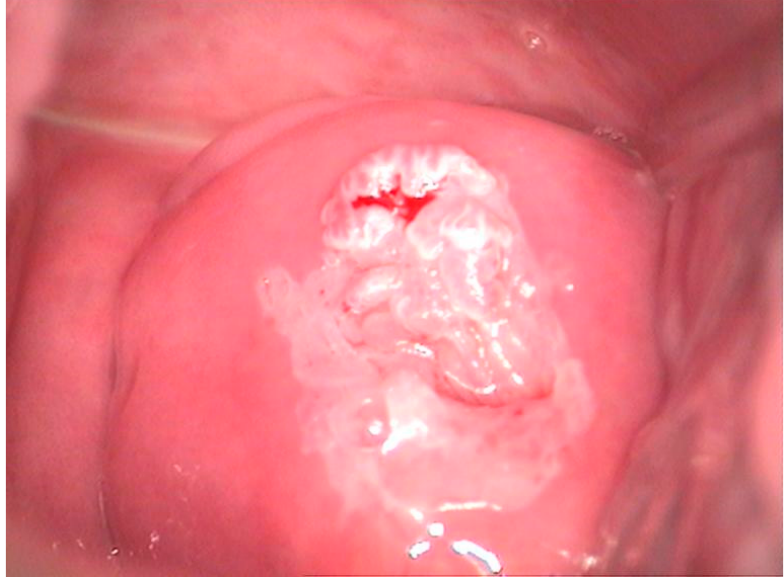
Figure 4. Colposcopic image after acetic acid application indicates aceto-white overriding epithelium on the entire anterior lip, suggesting condiloma acuminata. The lesion is ascending in the cervix, and its distal limit cannot be assessed.